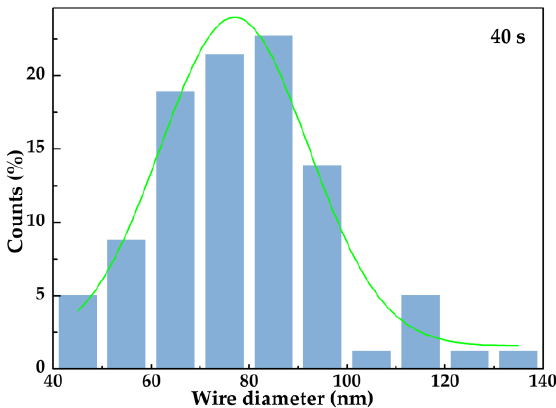
Figure 7. Wire diameter distribution of AgNWs deposited for 40 s.